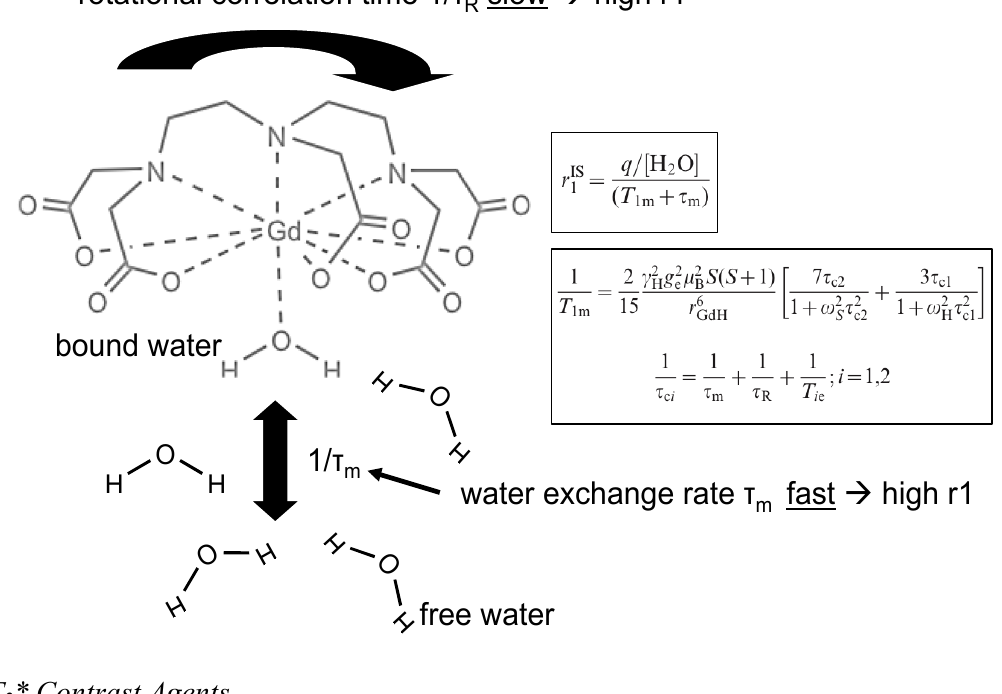
Figure 4. Schematic of water exchange between bound and free water of a gadolinium chelate. The proton bound to gadolinium exchanges its magnetic properties with the free water leading to a shortening of T in the vicinity of the contrast agent. Fast water 1 exchange leads to a more efficient energy transfer between Gadolinium and free water, . The amount of T shortening is given by the thereby creating a higher relaxivity r 1 1 relaxivity ( r ) of the contrast agent, which depends on the number of bound protons, the 1 water exchange rate (1/ τ ) and the T relaxation time of bound water (T ) [49]. T itself m 1 1m 1m depends on several factors including the distance to the gadolinium atom and the rotational correlation time (1/ τ ). Upon binding to a large protein or cell, 1/ τ significantly decreases r r thereby increasing r and thus increasing the T shortening effect of the contrast agent. 1 1 Construction of macromolecular agents (e.g., dendrimers) is another means of slowing down the rotational motion of Gd-compounds. The relationship between the relaxation time of bound water T (black box) and the inner sphere relaxivity r1 IS (black box) is given by the Solomon 1m Bloembergen equations [56] which are described in more detail in